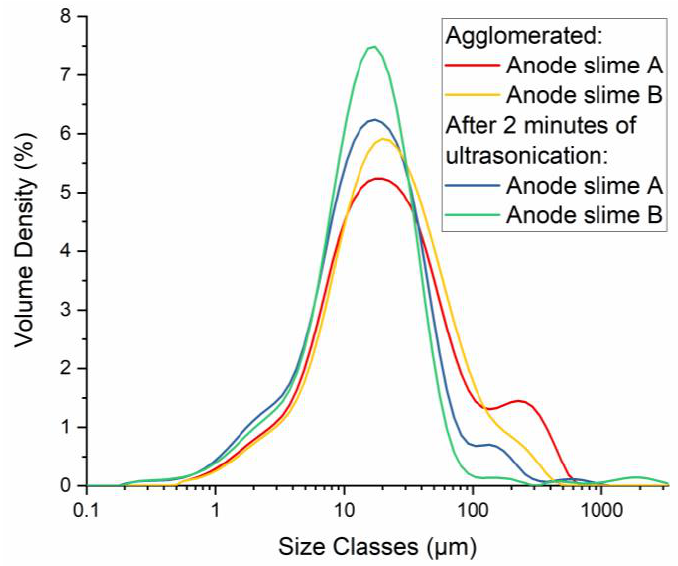
Figure 2. Particle size distribution of the industrial anode slimes. Synthetic anode slime (SS) was composed of NiO (powder, max. 45 µm, GoodFellow Cambridge Ltd, Huntingdon, UK) and Fe 2 O 3 (98% metal basis, −3 45 mesh powder, Alfa Aesar, Haverhill, MA, USA) at a ratio of 1:4. Synthetic electrolyte that contained 170 g/L (1.73 M) H 2 SO 4 , 60 g/L (0.95 M) Cu 2+ and 7 g/L (0.13 M) Fe 2+ was used in the experiments. Fe 2+ was added to the electrolyte to increase viscosity to levels similar to those found un- der industrial conditions. This synthetic electrolyte was made by dissolving copper sulfate pentahydrate (technical grade, VWR Chemicals, Leuven, Belgium) and iron sulfate hep- tahydrate (ACS, 99+%, Alfa Aesar, Haverhill, MA, USA) to 95% sulfuric acid (technical grade, VWR chemicals, Leuven, Belgium) that had been previously diluted with ion-ex- changed water. Thin copper sheets (C310) were used as anodes, and a steel plate (AISI 304) was used as the cathode. Epoxy (Loctite Power Epoxy 5 min Universal) was used to cover the back- sides of the anode and cathode to ensure that the active anode and cathode surface areas were approximately 15 cm 2 (3 cm × 5 cm). A thermometer was used to monitor the elec- trolyte temperature, and the cell was heated with an external water bath. Magnetic stirring was used to keep the solid particles in suspension. The particle size distribution of the industrial anode slimes was analyzed using a Malvern Mastersizer 3000 (Malvern Pana- lytical Ltd., Malvern, UK), and the industrial anode slimes were determined to have an average particle size of about 20 µm. Cathode deposit thicknesses of 100 µm were esti- mated to be sufficient for significant entrapment to occur, and electrorefining times were calculated based on this desired thickness. An overview of the experimental series used for the particle entrapment studies is shown in Table 2. Following the experiments, cathodes were rinsed with ion-exchanged water and eth- anol (99.5% Altia Oyj, Rajamäki, Finland). Cathodes were then cut into three separate seg- ments: One part was dissolved into aqua regia and analyzed for Ni content via atomic absorption spectroscopy (AAS, Thermo Fisher Scientific, Waltham, MA, USA), and Fe was also analyzed in cases with synthetic anode slime. The second section was mounted into epoxy for cross-section analysis, and the remaining part was left in an unmodified state for surface analysis. The cathode cross-sections were etched with a solution containing 28 – 30% ammonium hydroxide, 3% hydrogen peroxide and de-ionized water at a ratio of 5:5:1. These cathode cross-sections and the unmodified surfaces segments were analyzed with scanning electron microscopy and energy-dispersive X-ray spectroscopy (SEM-EDS, Tescan, Brno, Czech Republic).